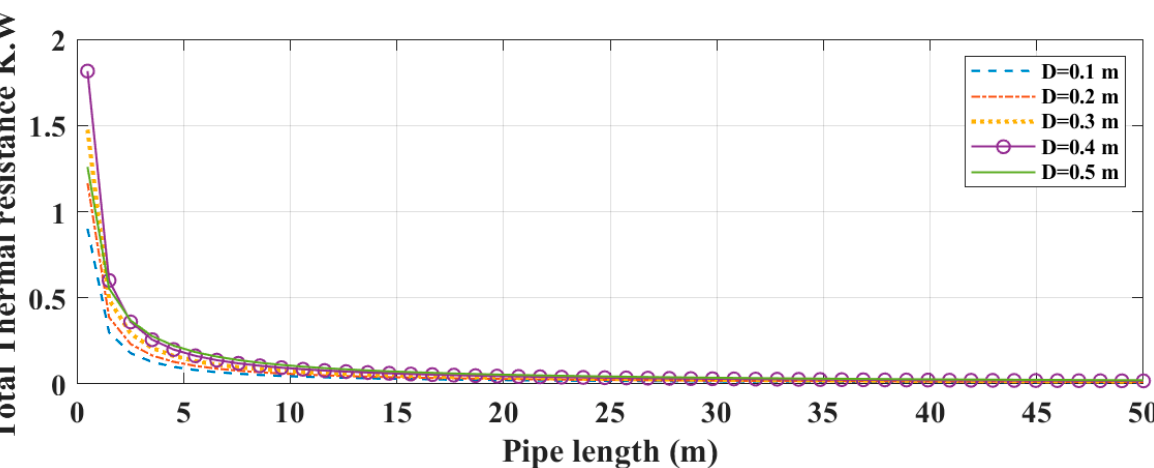
Figure 10. Total thermal resistance of the EAHE system as a function of pipe length and diameter.